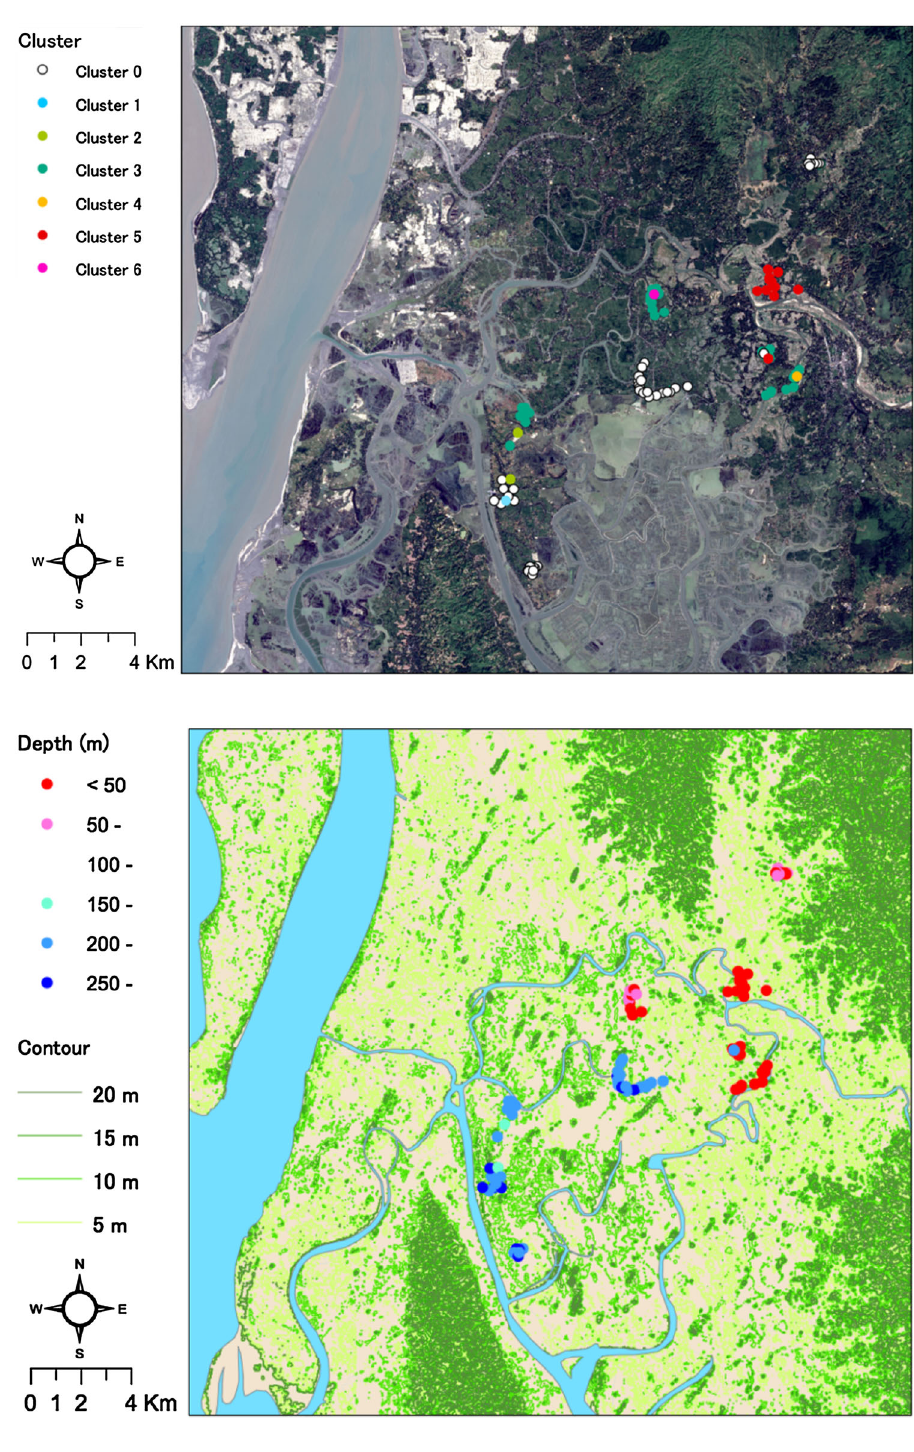
There was no tube well with depth from 100 m to 150